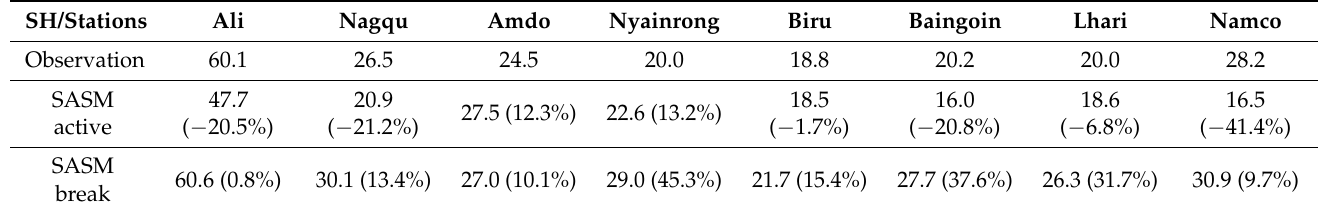
Table 2. Sensible heat flux (SH) (Wm − 2 ) over the 8 plateau stations, averaged for the observations and SASM active and break periods. The bracketed values denote the SH percentage increase (decrease) of the daily averaged value, in which positive (negative) values mean increasing (decreasing).